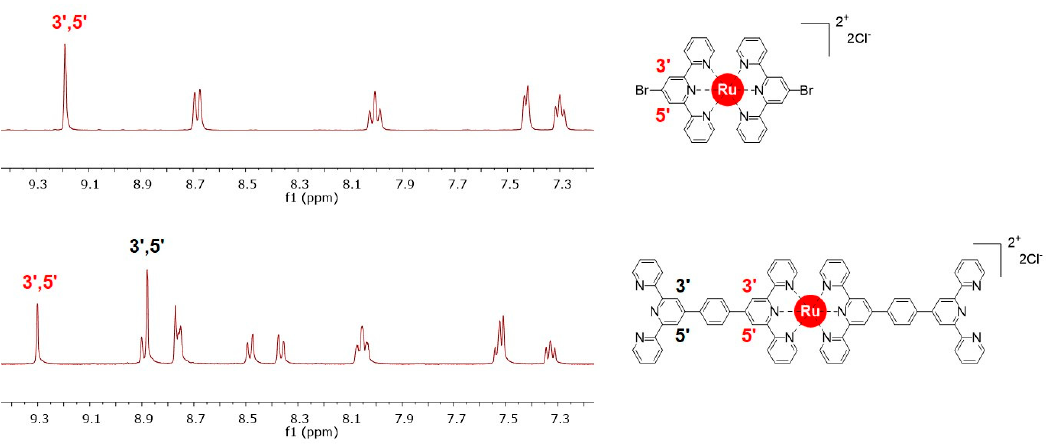
Figure 1. Comparison of the partial 1 H NMR spectra of compound 2 and compound 4